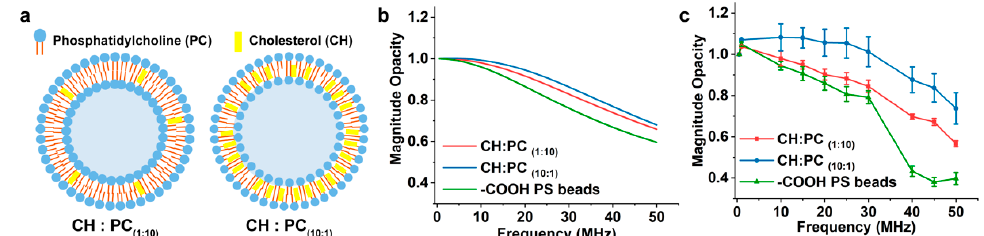
Figure 3. ( a ) Schematic representations of two types of liposomes with different membrane compo- sitions (CH:PC (1:10) and CH:PC (10:1) ). The relative magnitude opacity of liposomes and COOH-PS beads (the average size of all particles is 100 nm) utilizing ( b ) the mathematical model and ( c ) the experimental measurement. (n =